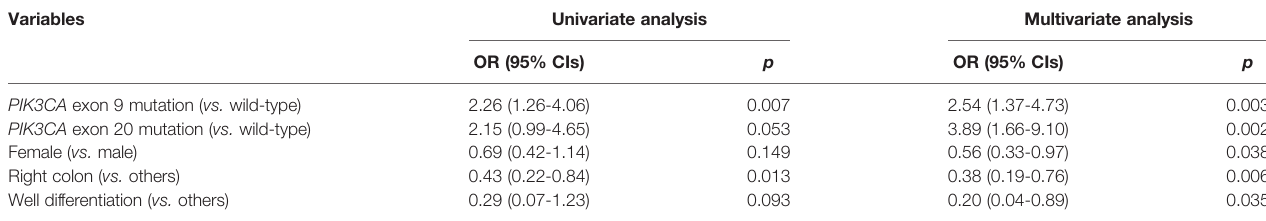
TABLE 4 | Univariate and multivariate analyses of disease recurrence at stage III CRC patients.